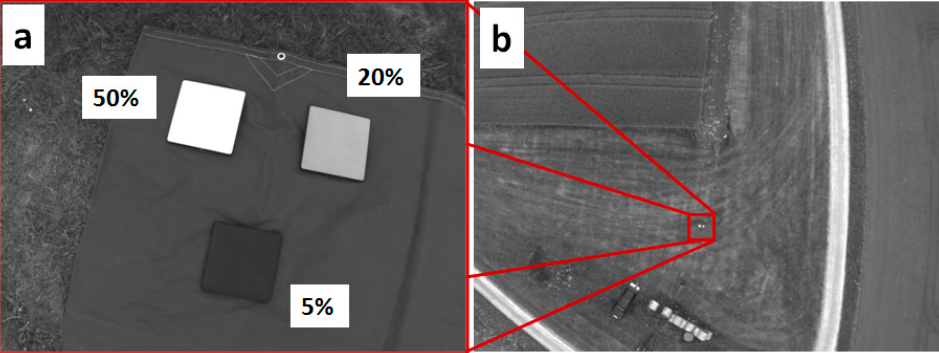
Figure 2. Spectralon reflectance calibration panels (25 × 25 cm) in images captured at 1 m ( a ) and 55 m ( b ) flying heights during the flight on 20 May 2019. Both images are in the green wavelength band.